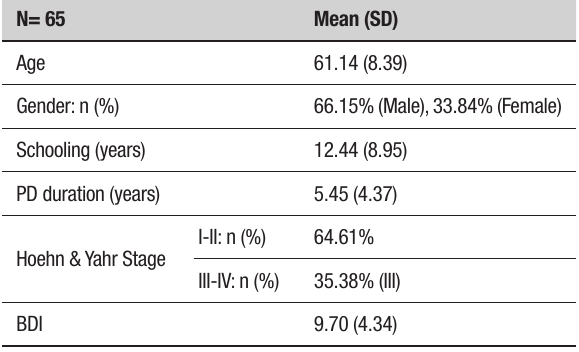
Table 1. Characteristics of the PD